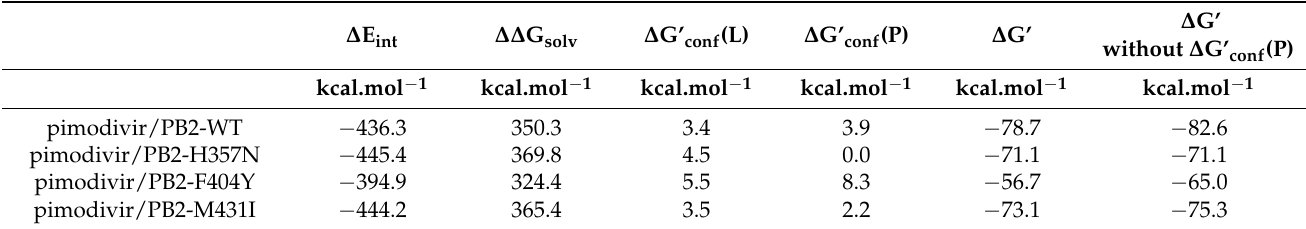
A considerably less negative ∆ E int of the pimodivir: PB2-F404Y complex can be indicative of the less negative enthalpic term measured by isothermal titration calorimetry (ITC). However, such a comparison requires a caution because part of the enthalpy is included in the interaction solvation free energy term. A detailed analysis of the results revealed that the studied mutations of PB2 affected the binding of pimodivir mainly by changing the “free” energy of the active site water molecules, see Figure 8 and Table 3.